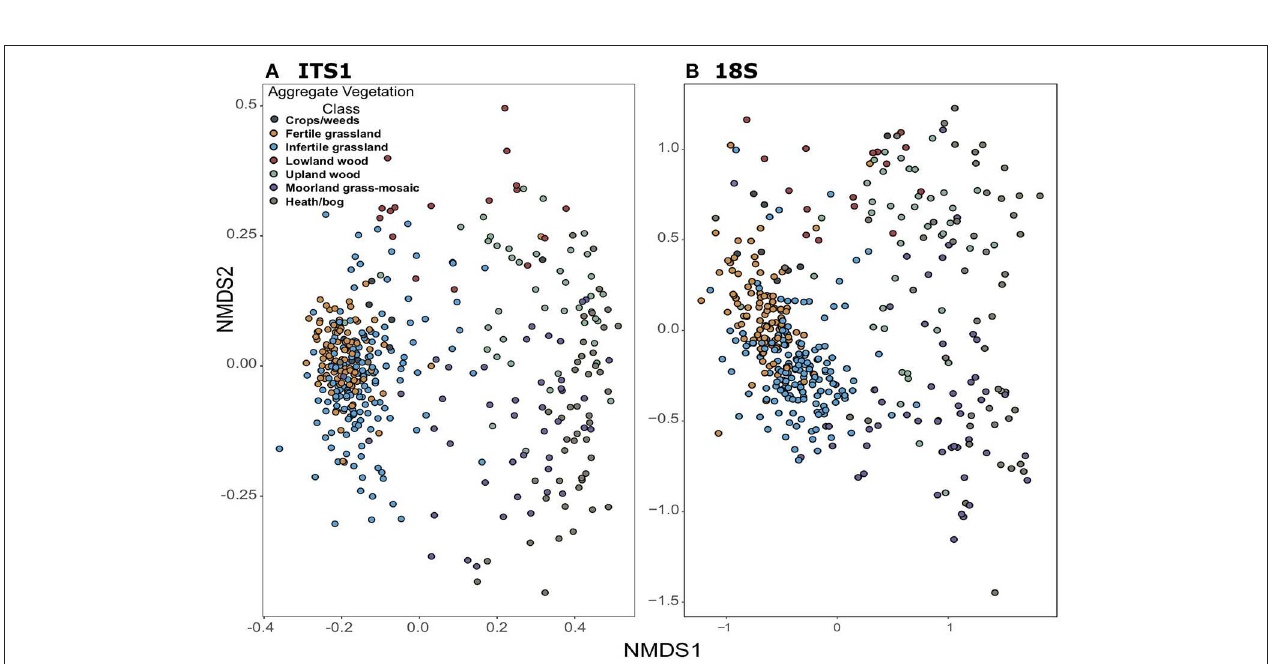
FIGURE 6 | Non-metric dimensional scaling ordinations of fungal community composition across GMEP sites. Samples are coloured by Aggregate Vegetation Class. Data from ITS1 (stress = 0.13) is shown in (A) ; data from 18S (stress = 0.11) is shown in (B) .